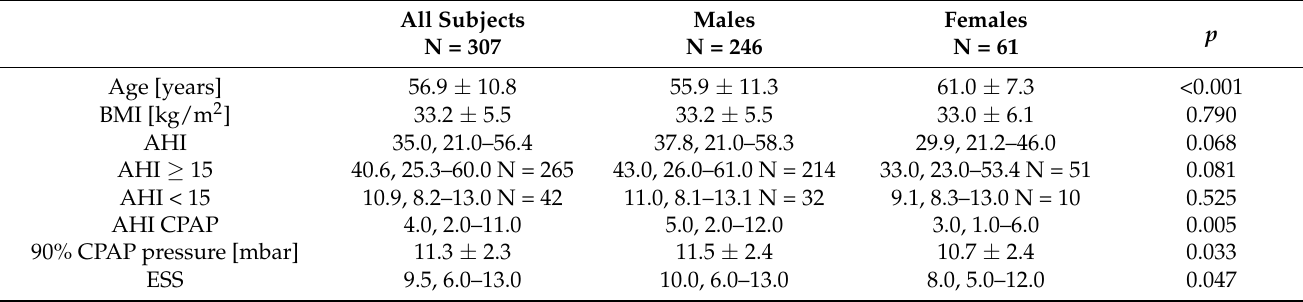
Table 1. Demographic and clinical characteristic of patients.